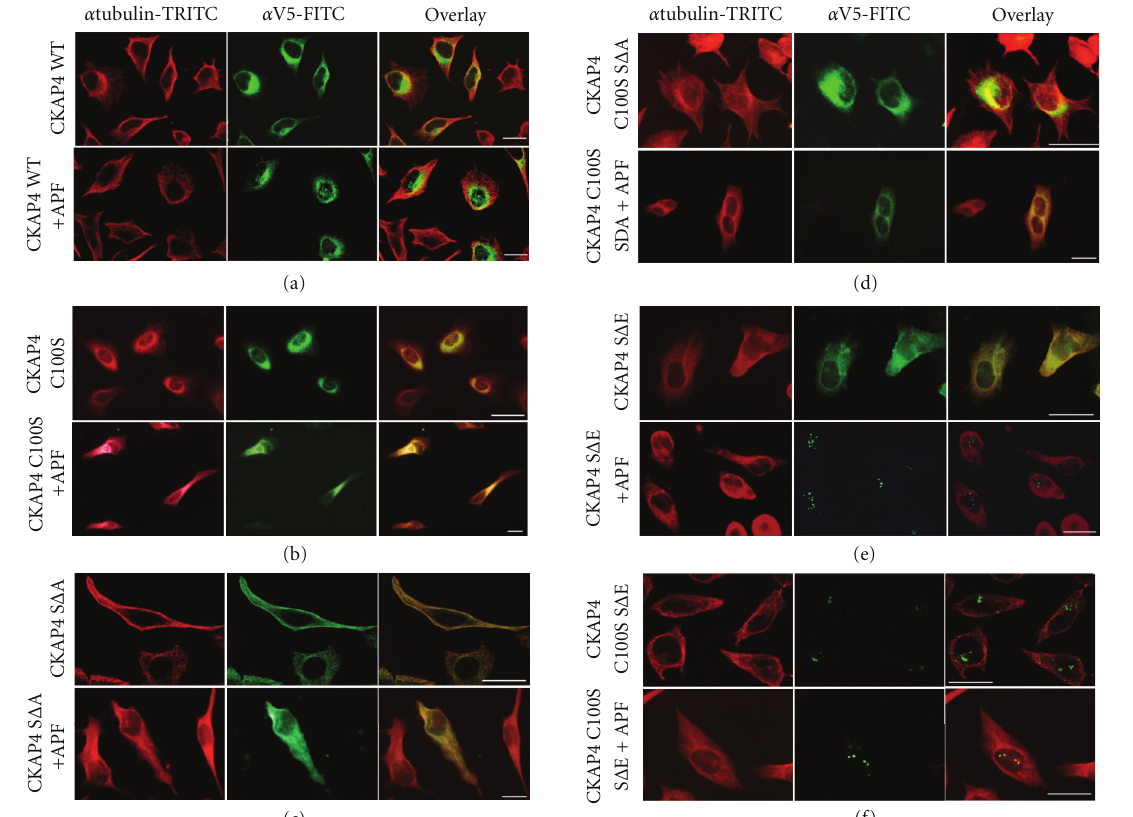
Figure 3: CKAP4 phosphorylation and palmitoylation regulate CKAP4 tra ffi cking . CKAP4 mutants that mimic constitutive depalmitoylation and various states of serine [3, 17, 19] phosphorylation were generated to determine the e ff ect of these two posttranslational modifications on the subcellular distribution of CKAP4 in response to APF (see Table 1). HeLa cells were transfected for 24–36 hours with the construct indicated to the left of each panel. Cells were serum starved for 6 hours and then treated with APF (20nM) for 18–24 hours. Subsequently, the cells were fixed in 4% bu ff ered paraformaldehyde, permeabilized with 0.1% Triton X-100, and immunostained for (1) β -tubulin (red; TRITC) and (2) V5 (green: FITC) (as described in Section 2) to distinguish the transfected, V5-epitope tagged WT (a) and mutant versions of CKAP4 from endogenous CKAP4 (b)–(d). Mutant versions of CKAP4 that cannot be palmitoylated (C100S) or phosphorylated (S Δ A) do not translocate to the nucleus in response to APF. (e) Those that mimic phosphorylation (S Δ E) translocate to the nucleus in response to APF. (f) CKAP4C100SS Δ E, which is constitutively depalmitoylated and phosphomimicking, is expressed primarily in the nucleus. Images taken in each channel were superimposed to illustrate the distribution of mutant CKAP4 with respect to the cytoskeleton. The cells were imaged by epifluorescence or confocal microscopy at 60X and 63X, respectively, (Scale bars = 25 microns).